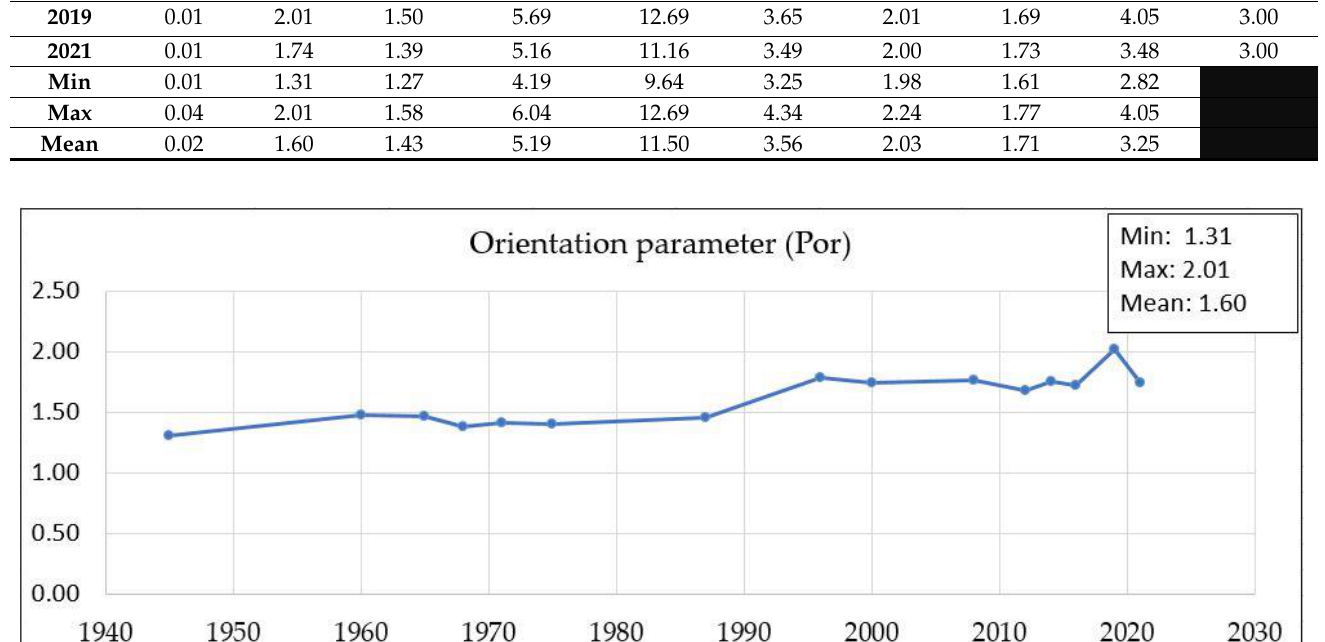
Figure 6. Lagoon’s orientation parameter fluctuations during the study period.